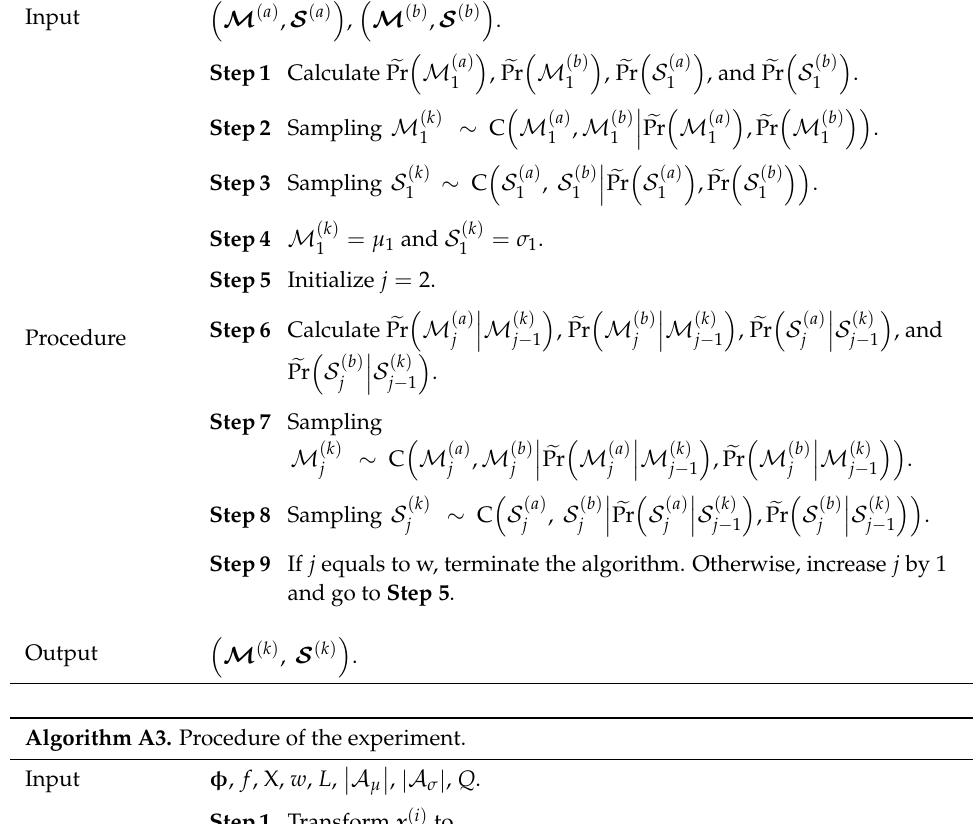
Algorithm A2. Alphabetical sequence generation.